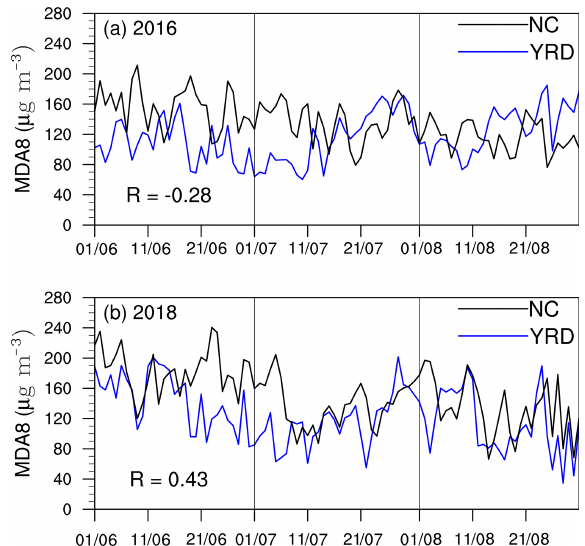
Figure 9. Variations in the MDA8 (unit: µgm − 3 ) of NC (black) and the YRD (blue) in 2016 (a) and 2018 (b) . The MDA8 was calculated as an average for all available sites in the NC and YRD